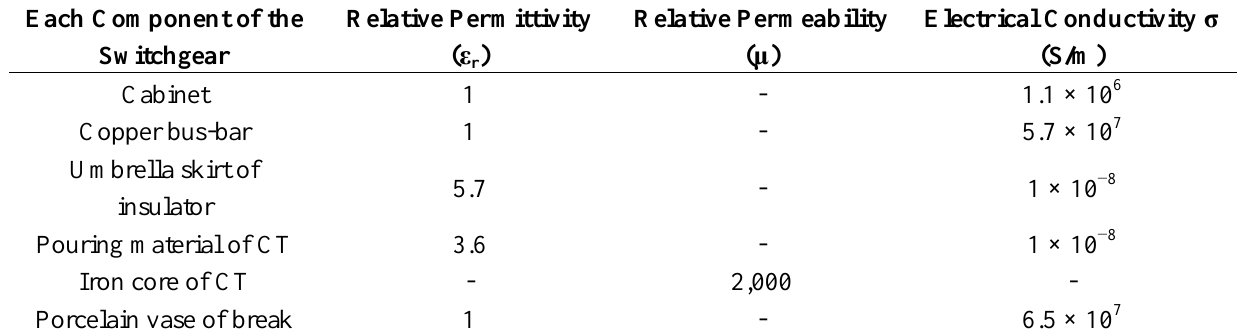
Table 3. The material parameters of each